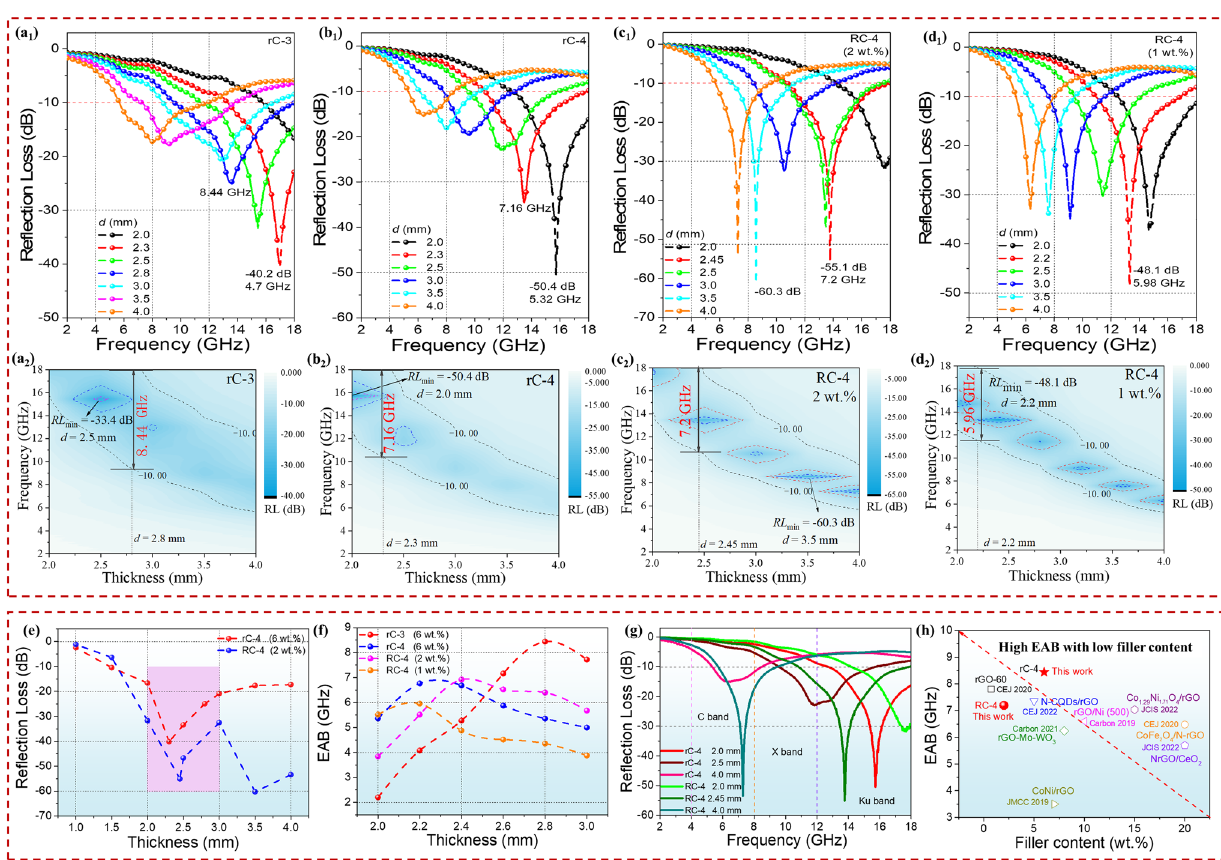
Fig. 3 RL curves: a 1 rC-3, b 1 rC-4, c 1 RC-4 (2 wt%) and d 1 RC-4 (1 wt%). 2D RL contour maps of a 2 rC-3, b 2 rC-4, c 2 RC-4 (2 wt%) and d 2 RC-4 (1 wt%). e RL min and f EAB at different thickness of rC-4 and RC-4. g Selected RL-f curves at various frequency wavebands. h Compari- son of MA performance considering the EAB and filler contents with reported rGO-based composite